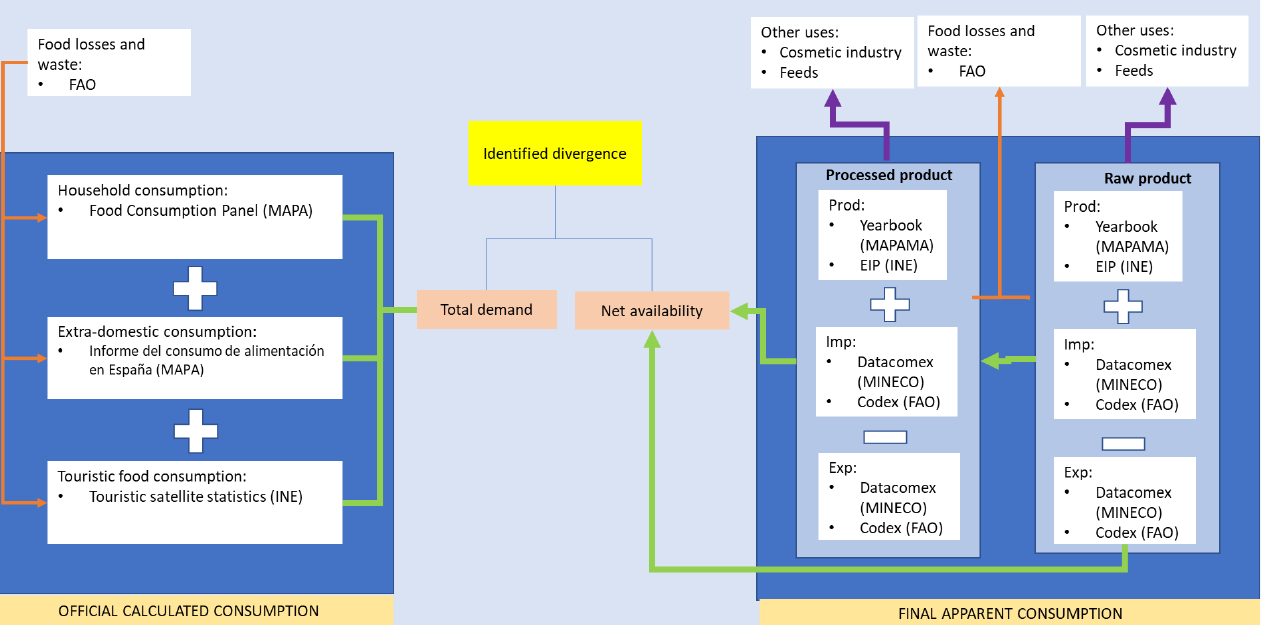
Figure 1. Methodological approach to calculate official consumption and final apparent consumption. The orange lines are the computed loss streams (added or subtracted). The green lines represent the amount of product that passes to the next phase of the food chain. The purple line indicates the output of the product to other uses. The existence of at least two generic phases in the transformation process was considered. They are related to the production of processed foods since they use part of the agricultural and livestock products for their production processes, although these phases may be more numerous. An example would be processed tomato, such as fried tomato, which has at least two consecutive phases: transformed tomato paste is used in its production (whose original raw material was fresh tomato in a previous phase), and crushed fresh tomato, combined in variable proportions (see Supplementary Material supported by references [25–53]).